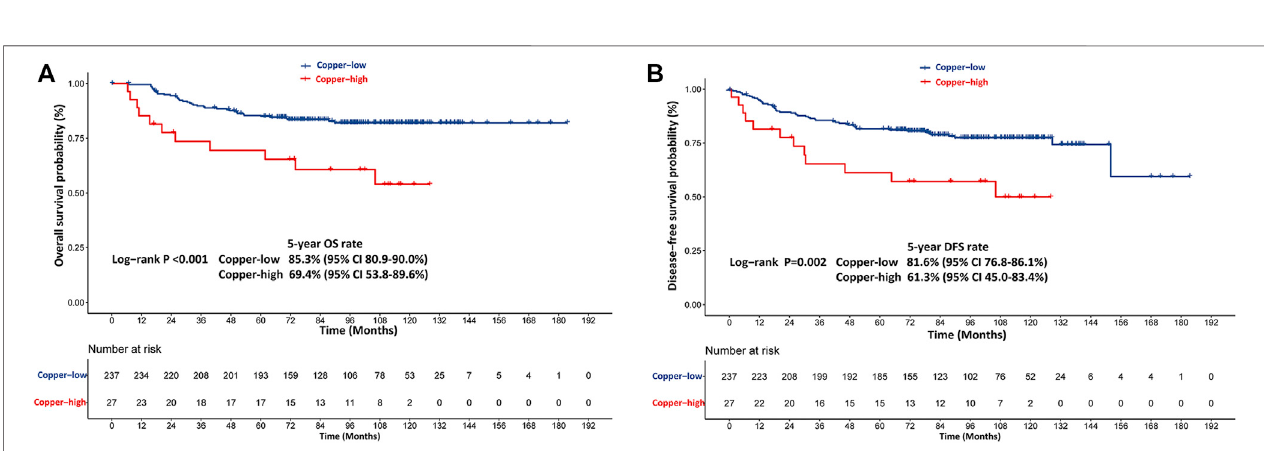
FIGURE 3 | Kaplan-Meier survival curves strati fi ed based on the baseline serum copper level in the training cohort. (A) Kaplan-Meier estimates of disease-free survival (DFS) probability. (B) Kaplan-Meier estimates of overall survival (OS) probability. Copper-low level: ≤ 21.3 μ mol/L, Copper-high level: > 21.3 μ mol/L.